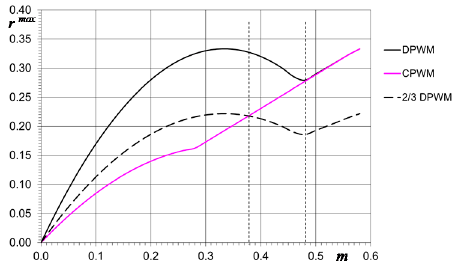
Figure 18. Maximum of normalized peak ‐ to ‐ peak current ripple as the function of modulation index for different modulation techniques.